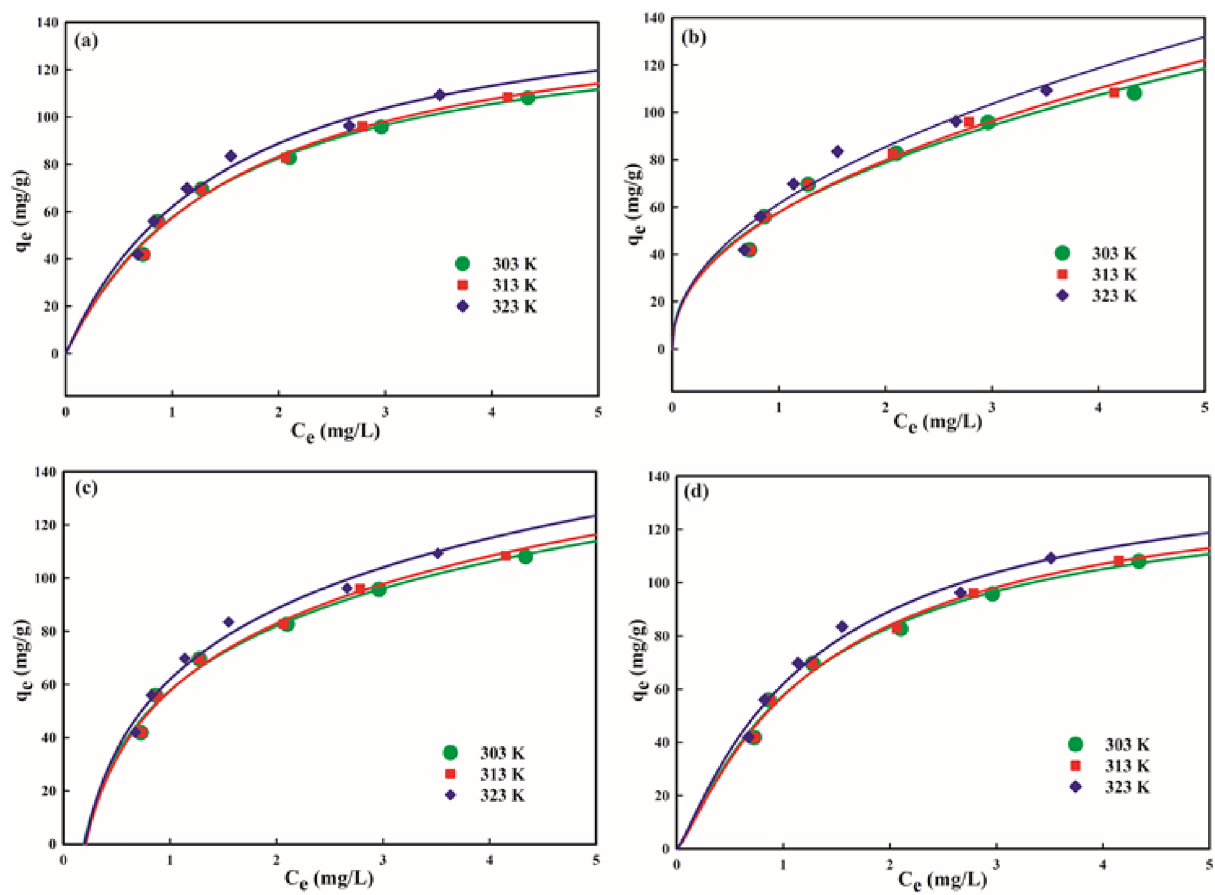
Figure 6. Isotherm plots: ( a ) Langmuir, ( b ) Freundlich, ( c ) Temkin, and ( d ) D-R for NB